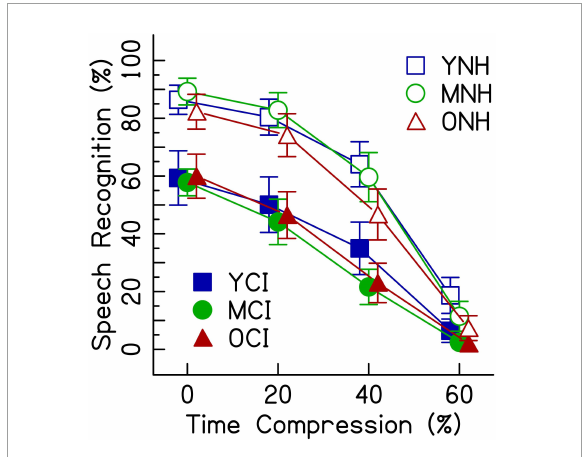
FIGURE4 Speech recognition performance in percent correct for listeners with CIs and listeners with NH presented 8-channel noise vocoded speech. Each listening group had three age groups (younger, middle-aged, and older) and listened to four rates of time compression (0, 20, 40, and 60%). Error bars show ± 1 standard